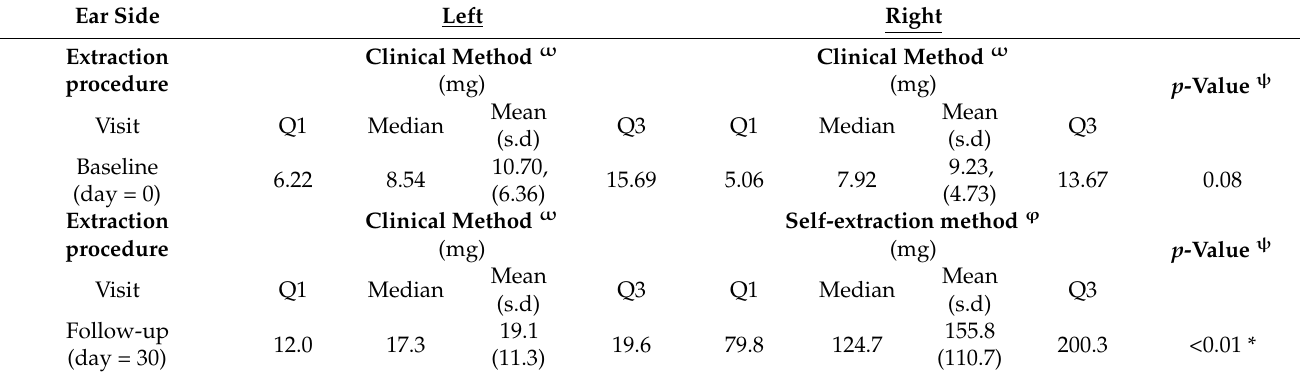
Table 4. Earwax Extraction Method